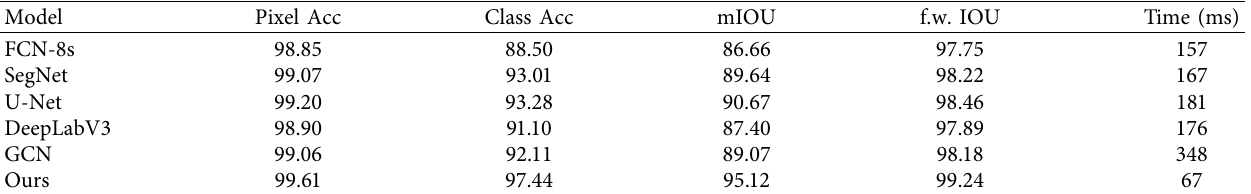
Table 5: Experimental results of our method against other state-of-the-art methods on the Insulator test dataset comparison of our method against other state-of-the-art methods on the Insulator test